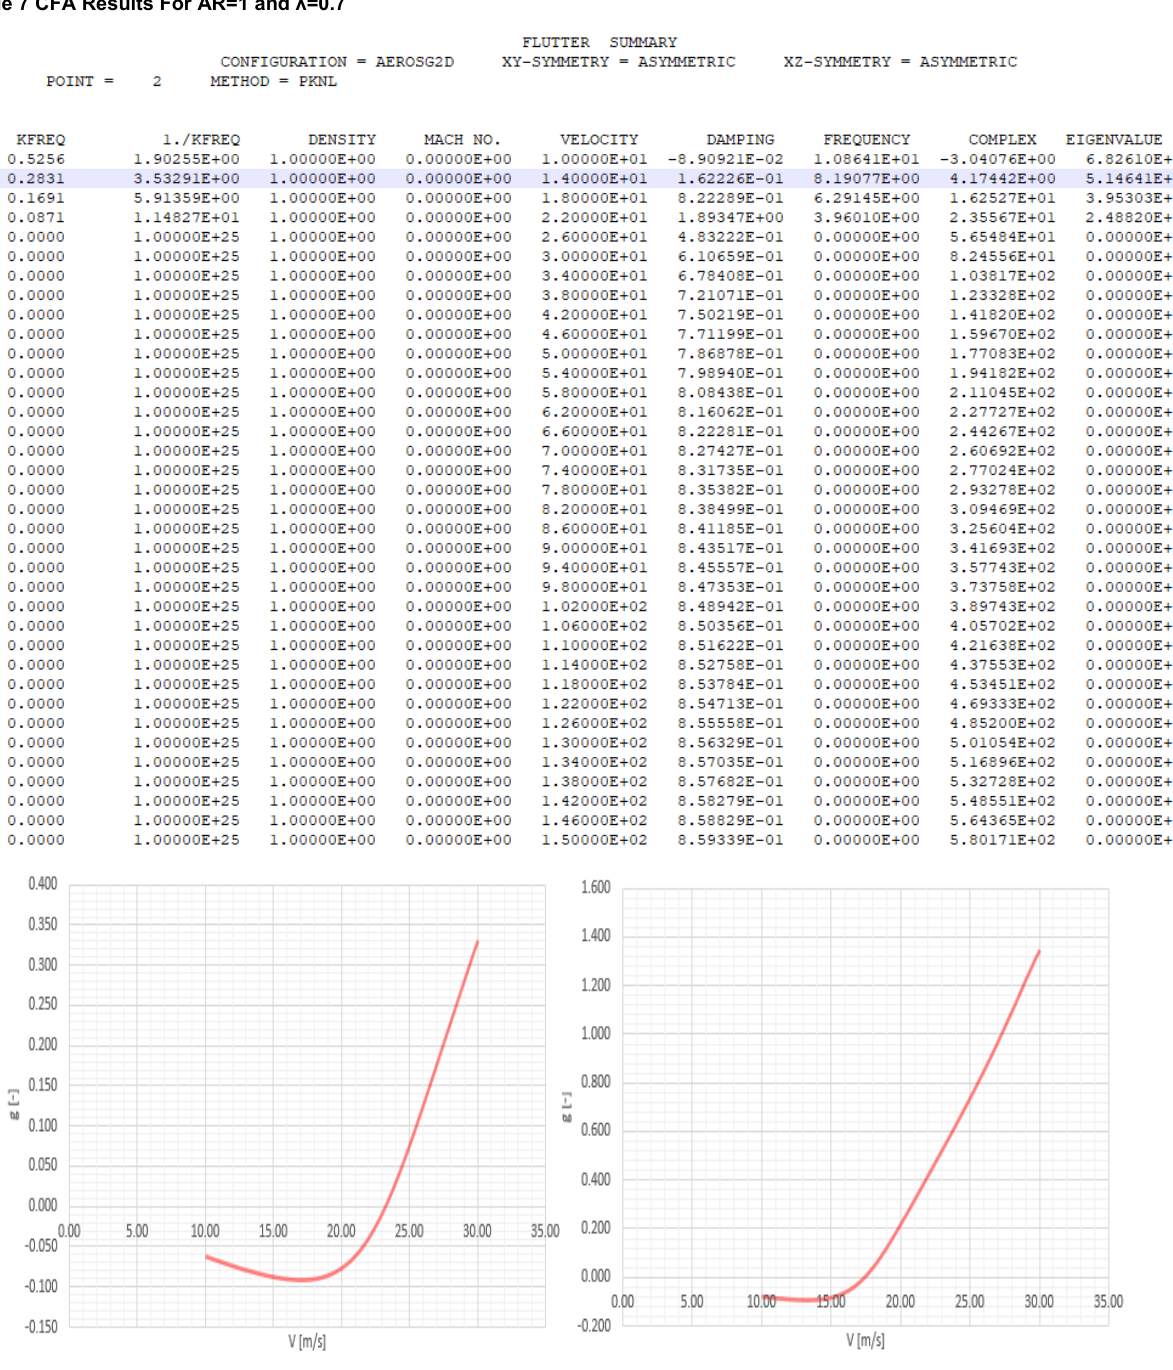
Figure 14. Effect of material on flutter speeds, EGlass/Epoxy and Carbon